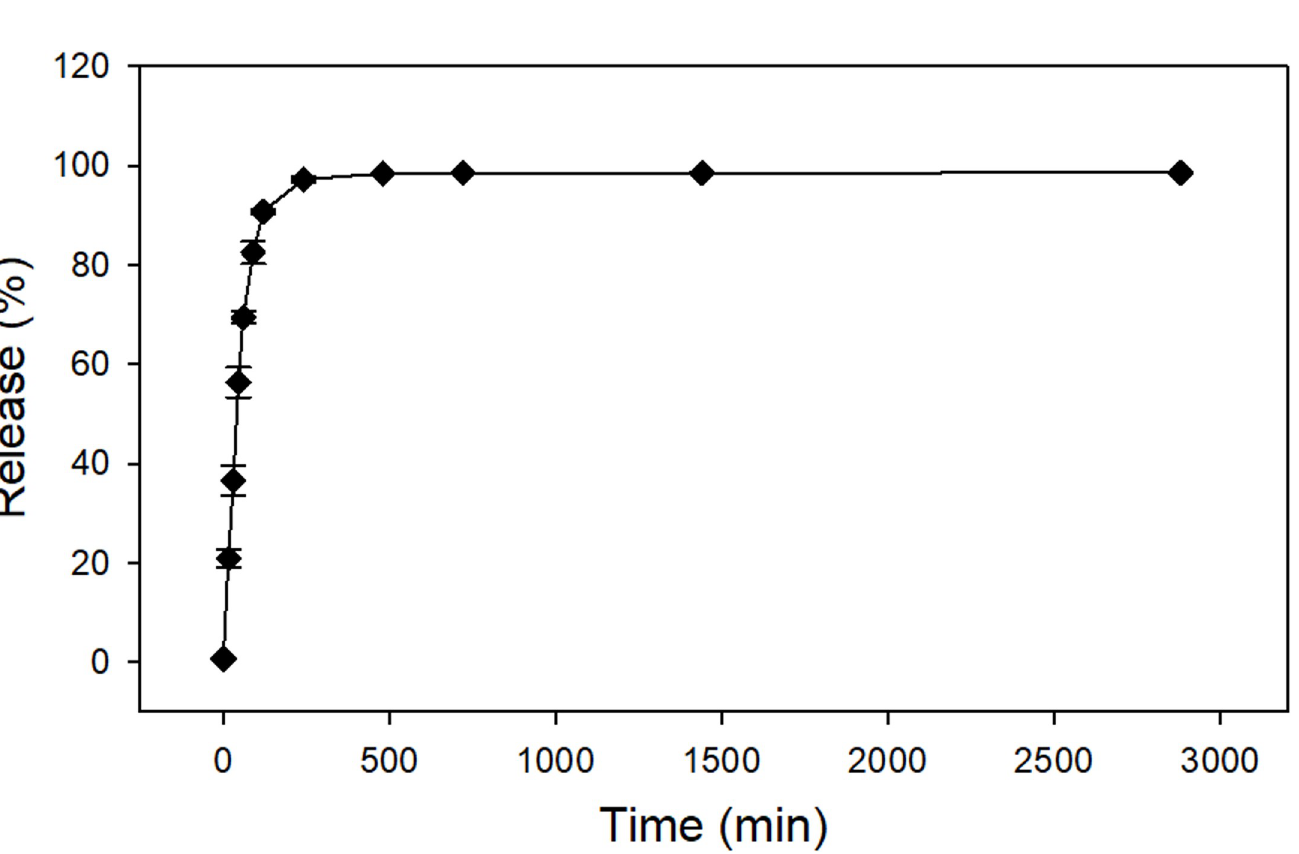
Fig 2. Selenium controlled release. Se released from chitosan nanoparticles over 48 h (2880 min) in phosphate buffer saline at pH 7.4 and temperature of 28˚C. Data shown as mean ± standard deviation, n = 3.